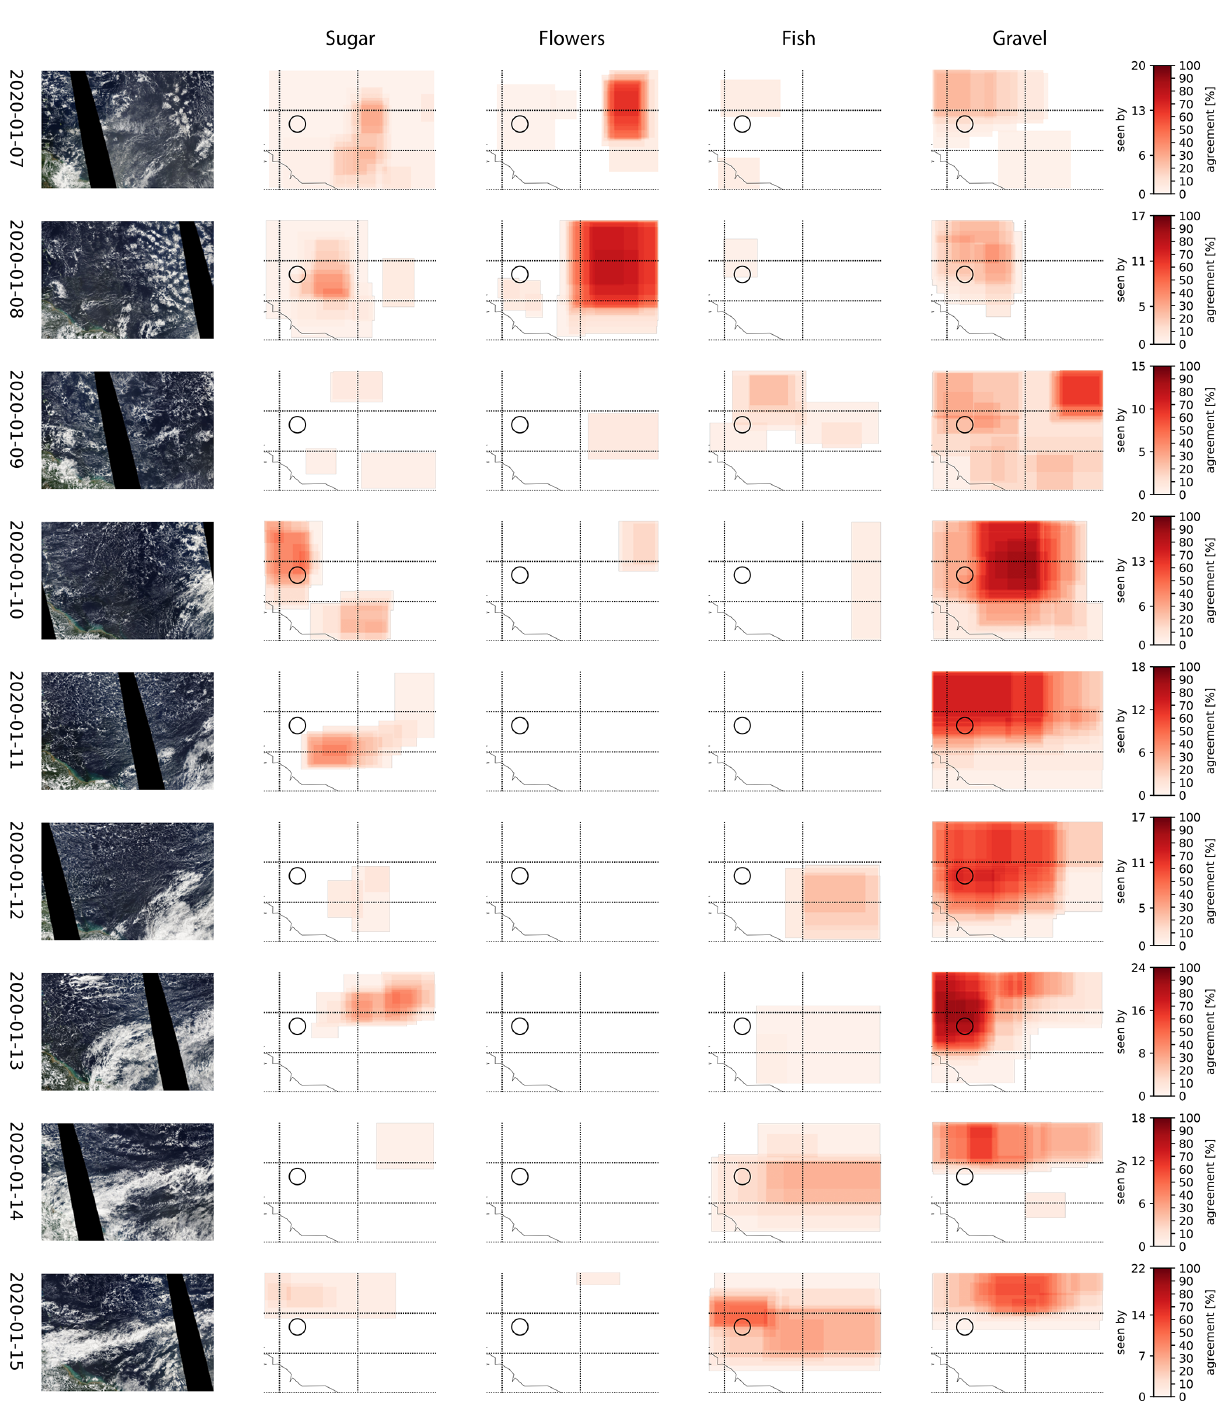
https://doi.org/10.5194/essd-14-1233-2022 Earth Syst. Sci. Data, 14, 1233–1256,